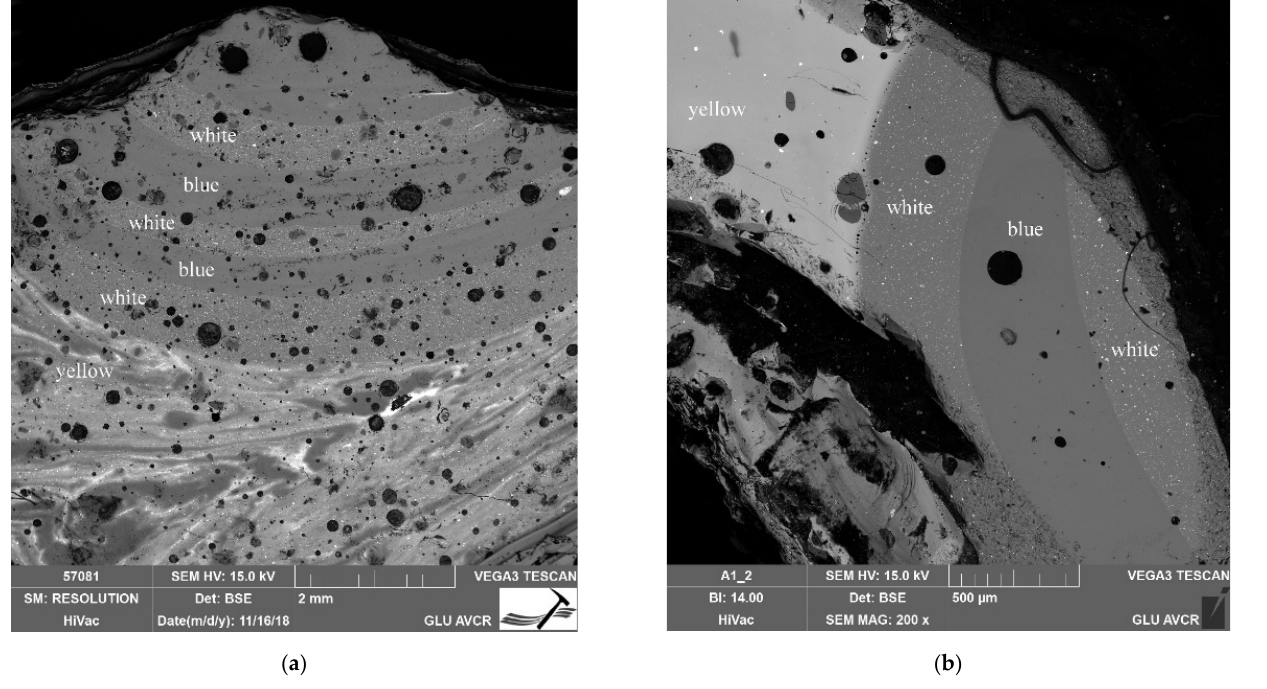
Figure 11. Glass Layer Stratigraphy of bead No. 23 and 26. ( a ) Layer stratigraphy, again showing highly inhomogeneous yellow glass and a large number of bubbles in all types of the glass represented; ( b ) In the case of bead No. 26, the yellow glass is relatively homogeneous (lighter area on the far left) with apparent partial dissolution of the opacifier.